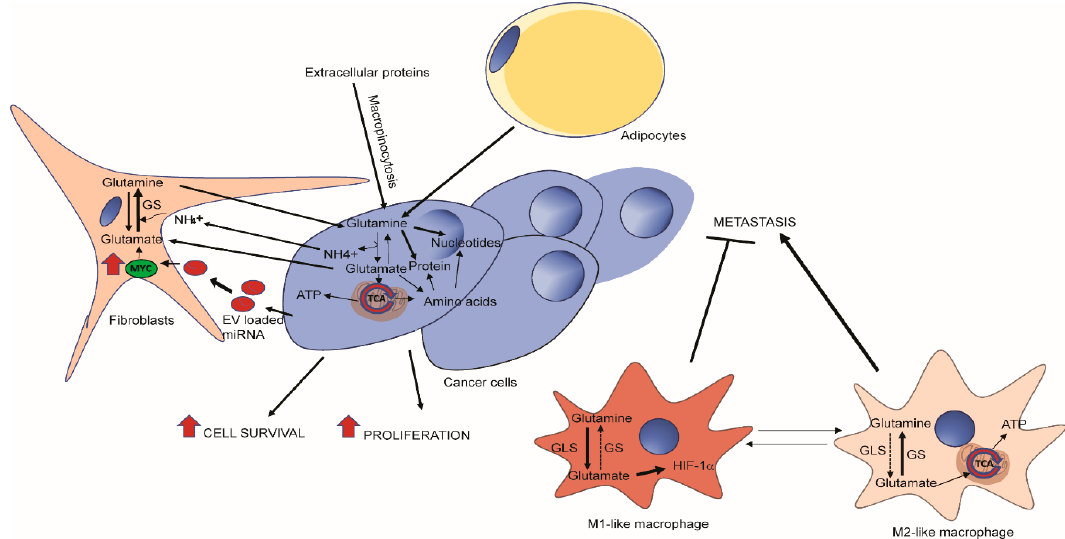
Figure 2. Glutamine metabolism in tumor microenvironment. Tumor cells can obtain glutamine via macropinocytosis of extracellular proteins, or via the import of free glutamine secreted by cancer ‐ associated fibroblasts (CAFs) or adipocytes [47,92]. Tumor cells communicate with CAFs via instructional miRNAs in exosomal vesicles (EVs) and secrets glutamate and ammonia as wastes that can be taken up by CAFs for glutamine synthesis [93]. In a cell autonomous manner, a decrease in glutamine synthetase activity in tumor ‐ associated macrophages (TAMs) can reprogram glucose and glutamine metabolism and lead to polarizing cells from an M2 to M1 ‐ like phenotype which inhibits metastasis [43].